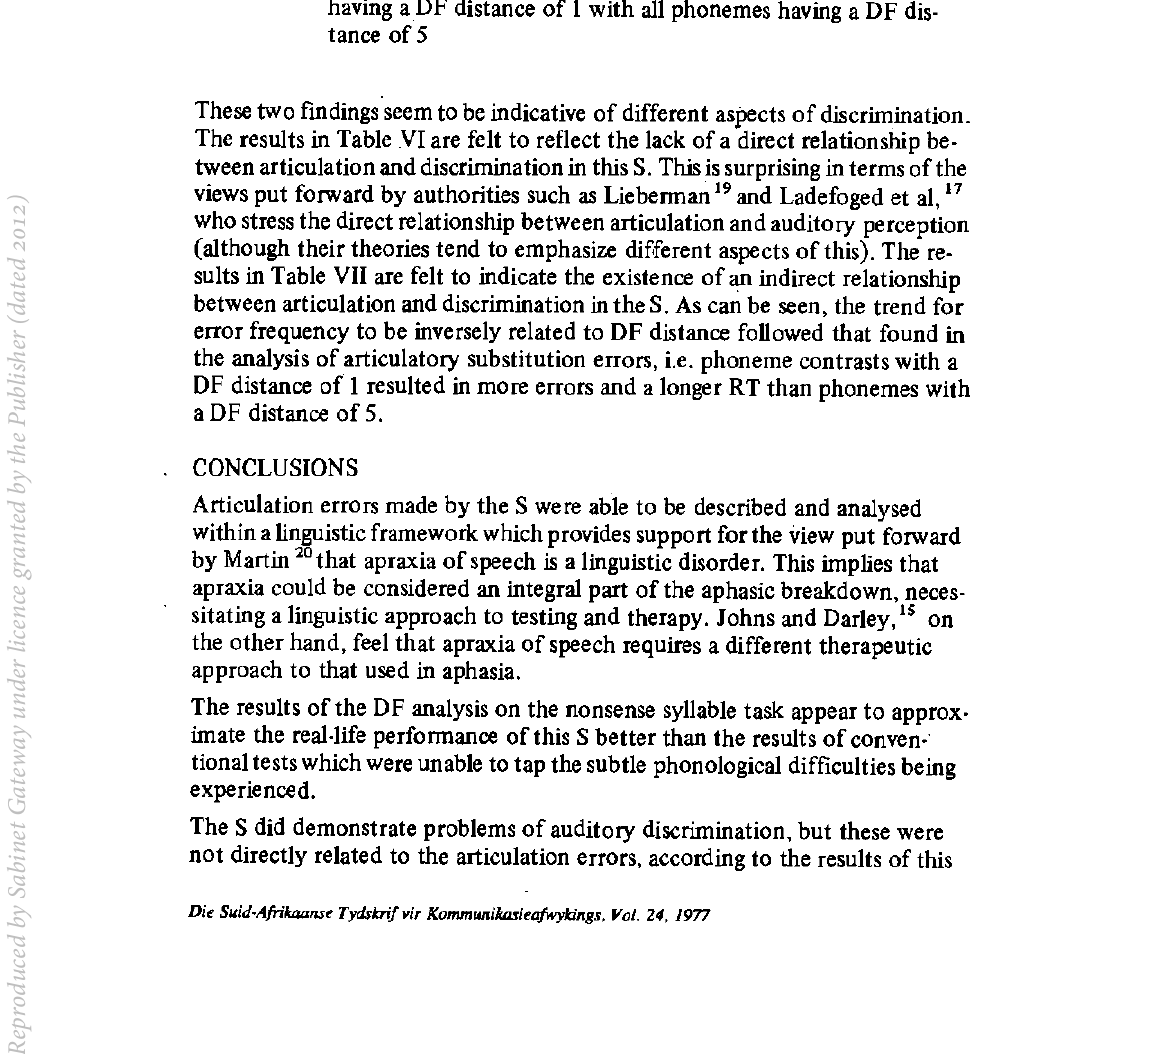
TABLE VII: A comparison between the discrimination of all phoneme pairs having a DF distance of 1 with all phonemes having a DF dis- tance of